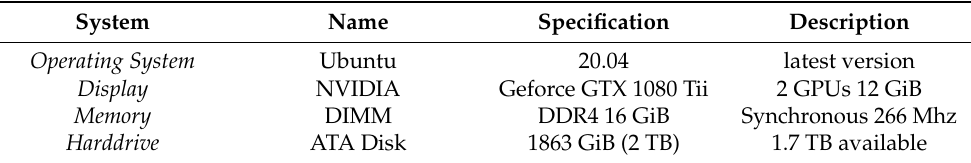
Table 1. System requirements for running the